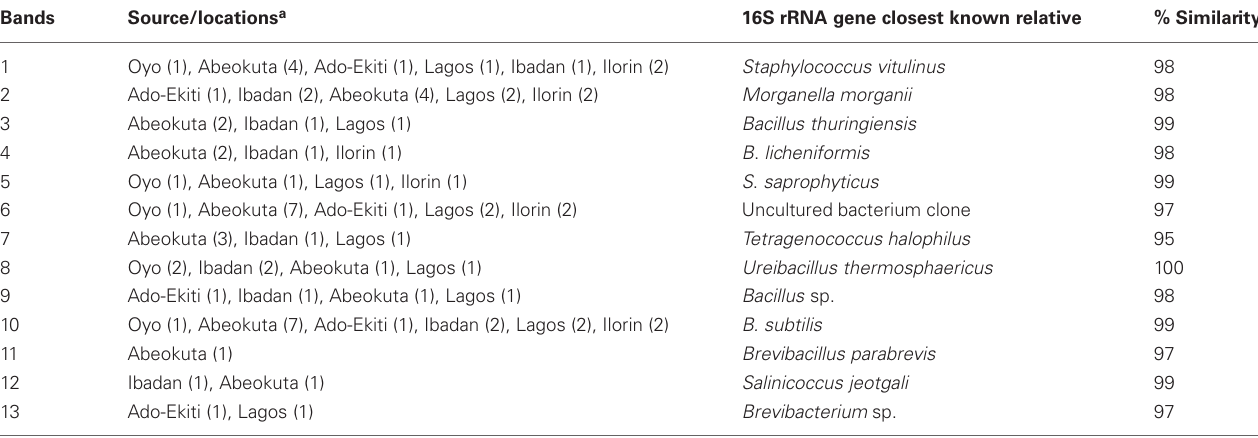
Table 3 | Identities of major bacterial bands excised from PCR-DGGE gels of fermented Parkia biglobosa seeds. Bands Source/locations a